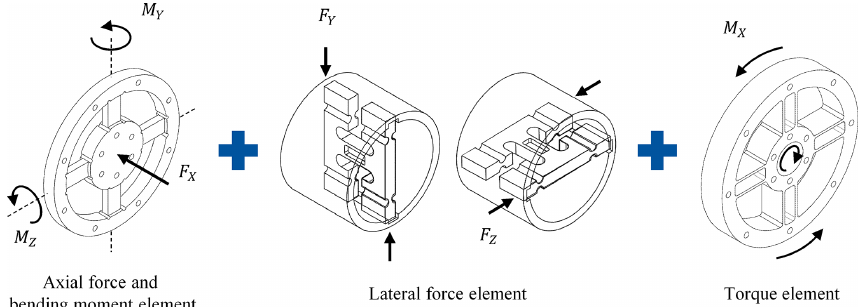
Figure 3. Selected design concept for the MCT.